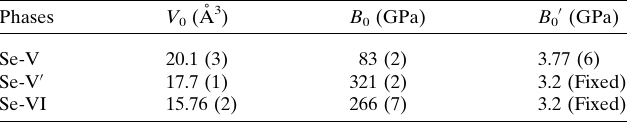
Table 1 The EoS parameters of selected Se high-pressure phases. Reference volume V 0 , bulk modulus B 0 and the derivative of the bulk modulus with respect to pressure B 0 0 , obtained from the least-squares fitting of the experimental data according to the third-order Birch–Murnaghan EoS. Values in brackets are estimated standard uncertainties and refer to the least significant digit; they reflect only the uncertainties derived from fitting V versus P points to the